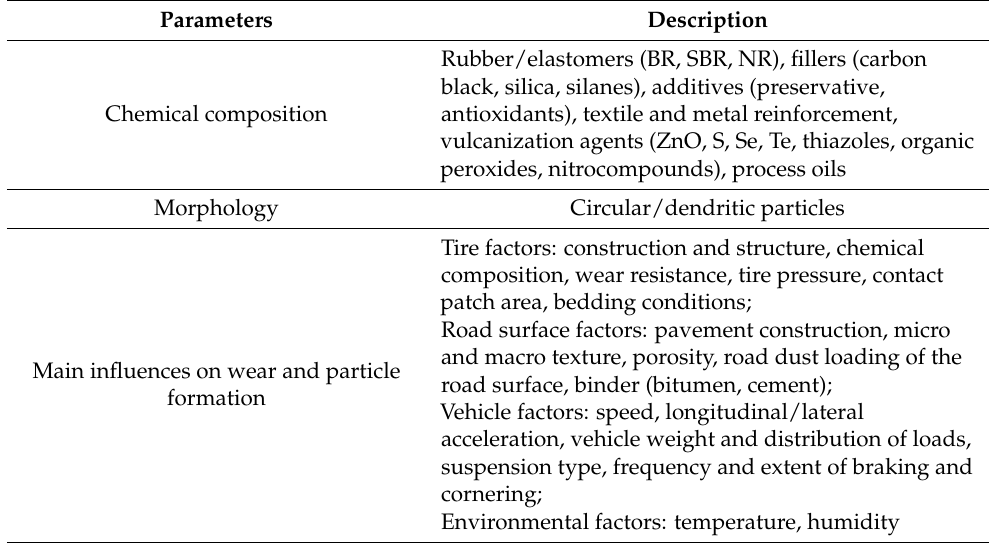
Table 1. Properties of tire wear particle emissions [11,18,22,25,26]. Parameters Description